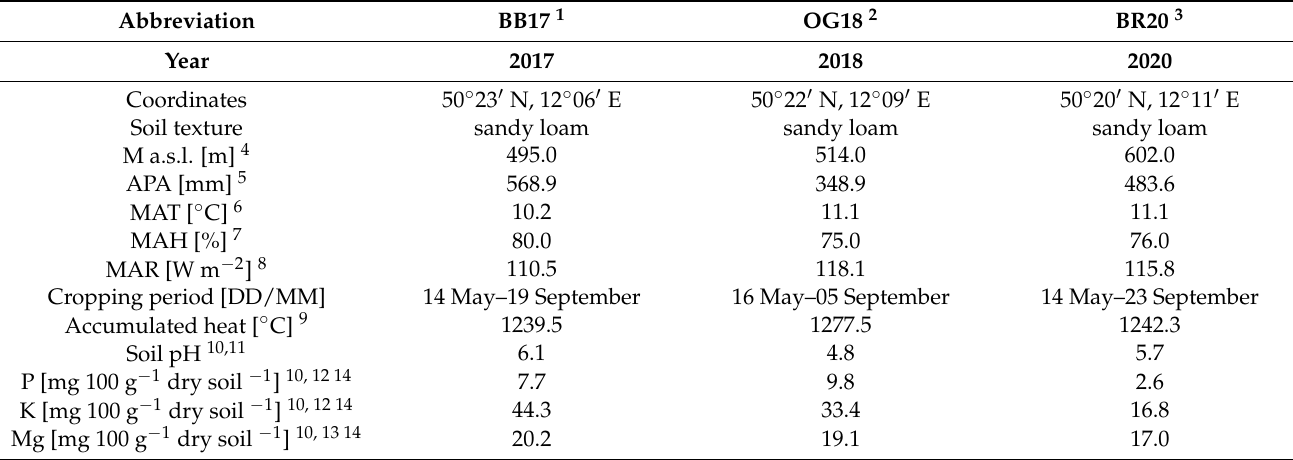
Table 1. Characterisation of experimental sites and